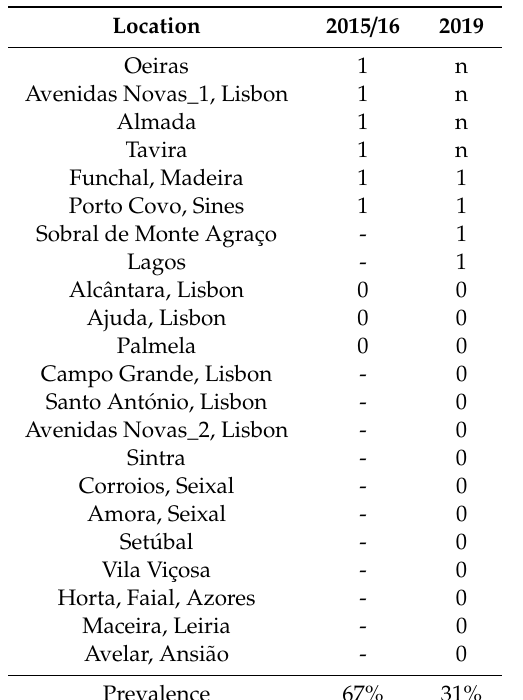
Table 1. Survey of daylily rust 1 in Portugal in 2019, compared to previous surveys (in 2015 or 2016; [15]), including the reference of the isolate and the evolution of national prevalence.